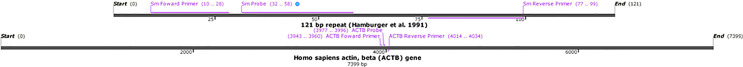
Diagram showing anneling positions of the primers and probes in the 121 bp and human β-actin gene sequences. SnapGene software (from Insightful Science; available at snapgene.com).